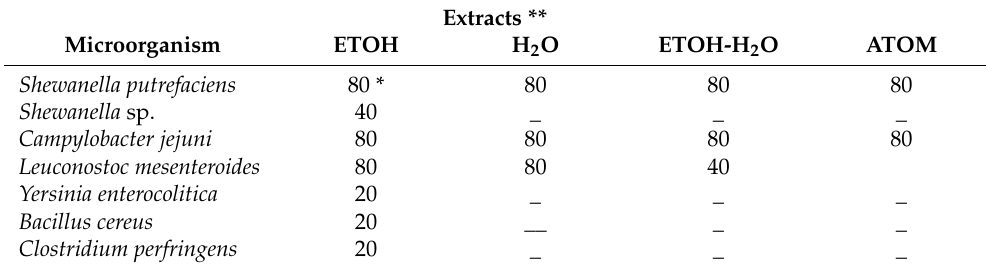
Table 3. Minimum inhibitory concentration (MIC) of extracts of S. ecuadorensis (mg/mL). Extracts